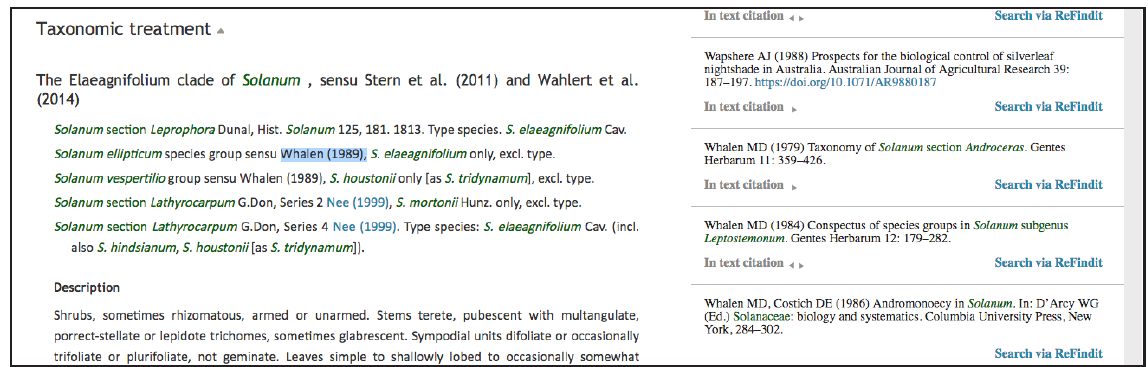
Fig. 1. The reference highlighted in yellow is listed under the references section, even though it has not been cited anywhere else in the article (Coritico et al. 2017).